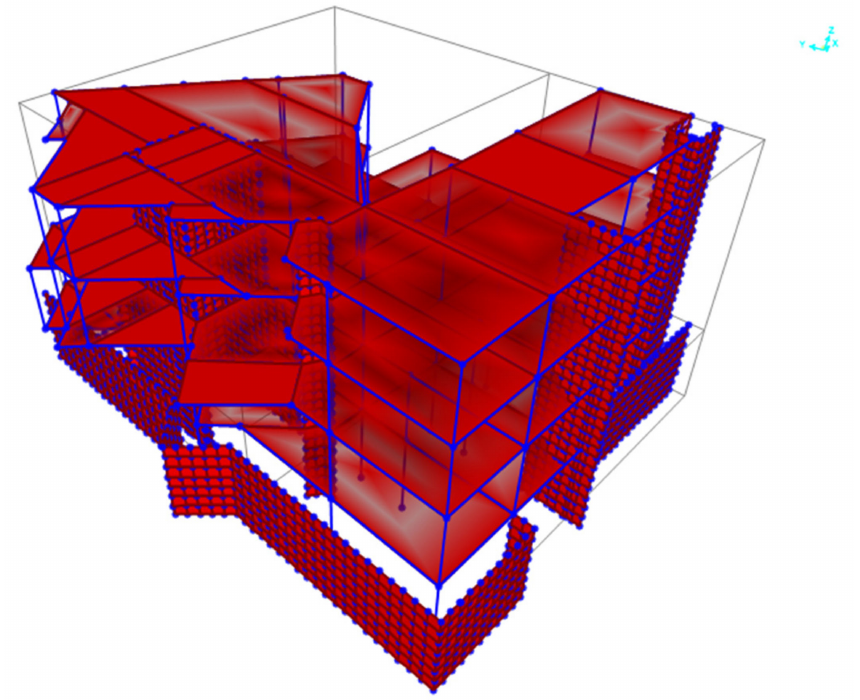
Figure 6. 3D view of the FE model of the “Municipal Headquarters” of Palagianello without infill walls defined by means of